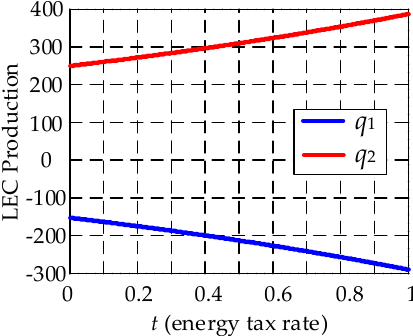
Figure 3. Productions vs. the energy tax rate.